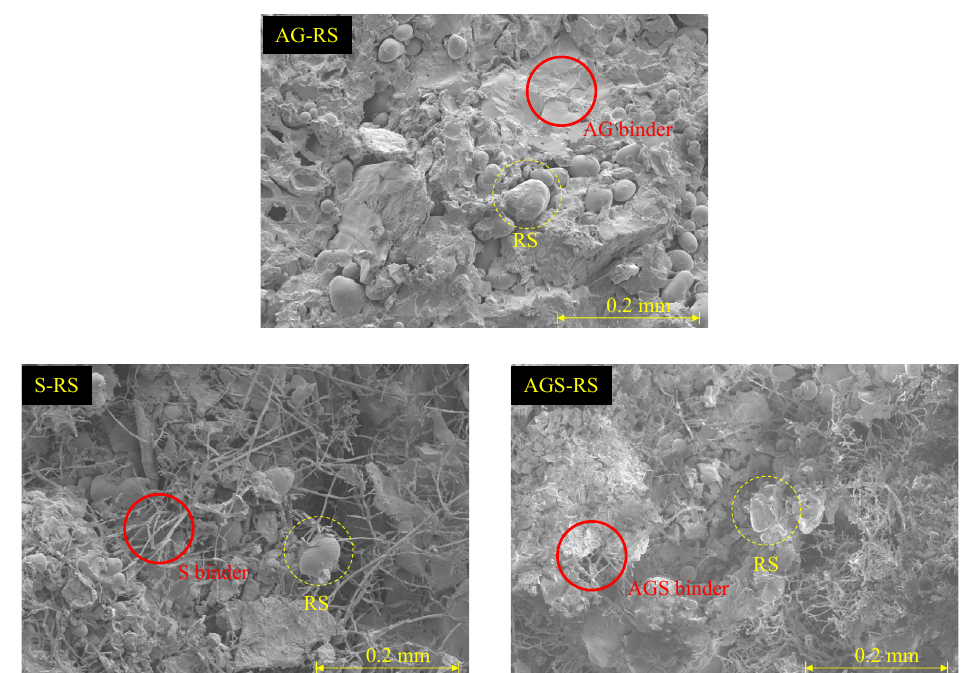
Figure 5. Scanning electrochemical microscopy photo of the AG-RC, S-RC, and AGS-RC samples.